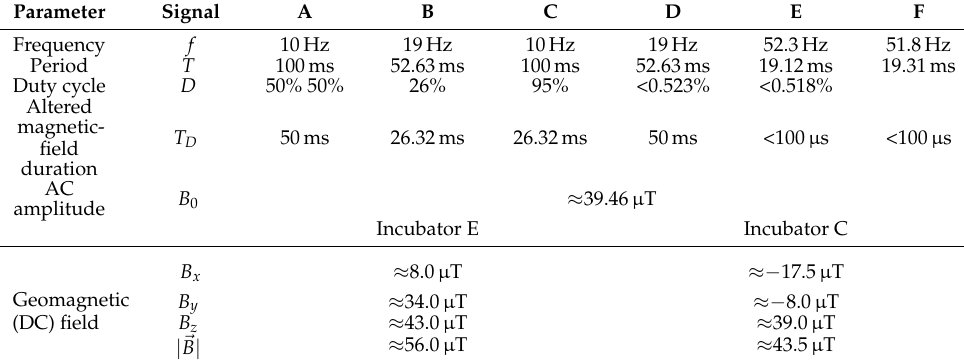
Table 2. Summary of the magnetic-field parameters. Frequency f , period T , duty cycle D and the altered magnetic-field duration T D related to the duty cycle by Equation (1). The definition of T D is shown in Figure 2A. The geomagnetic background field was measured with a 3-axis magnetic-field sensor positioned by a custom-made travel drive apparatus after building up the experimental setup in the lab. Here, we summarize characteristic values for the components and the total magnetic field at relevant well position, e.g., D5. Further information on the field distributions for both incubators are shown in the supplement, Figures S5 and S6. In total, 6 signals were tested. They all have the same amplitude and the same geomagnetic background field homogeneity in both incubators (IC E and IC C). Signals A–D are rectangular while E and F are very short-pulsed and of triangular